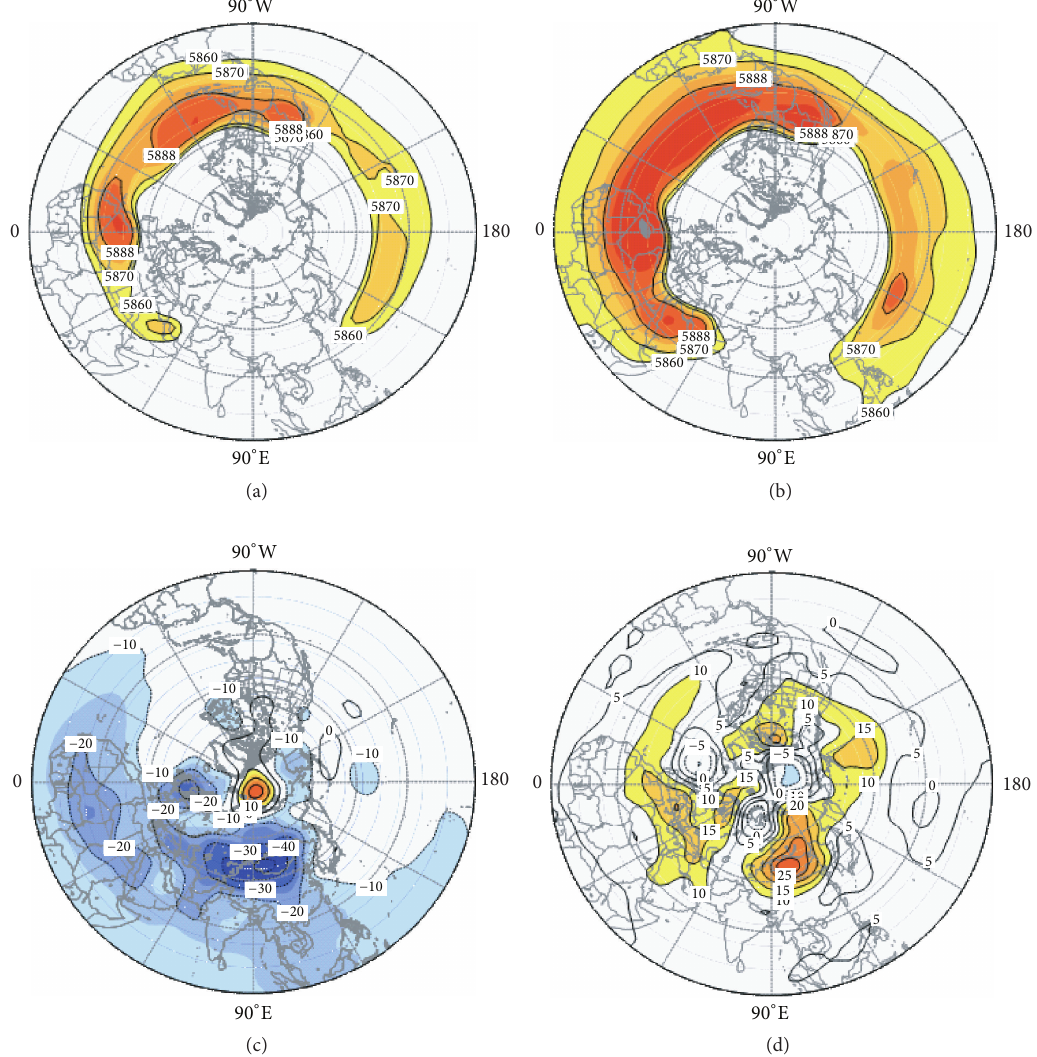
Figure 5: The mean and difference of geopotential height distribution at 500 hPa during the summer (JJA). The mean for the periods of (a) 1959–1966 and (b) 1997–2003, (c) the difference between 1959–1966 and 1958–2010, and (d) the difference between 1997–2003 and 1958–2010. Unit: